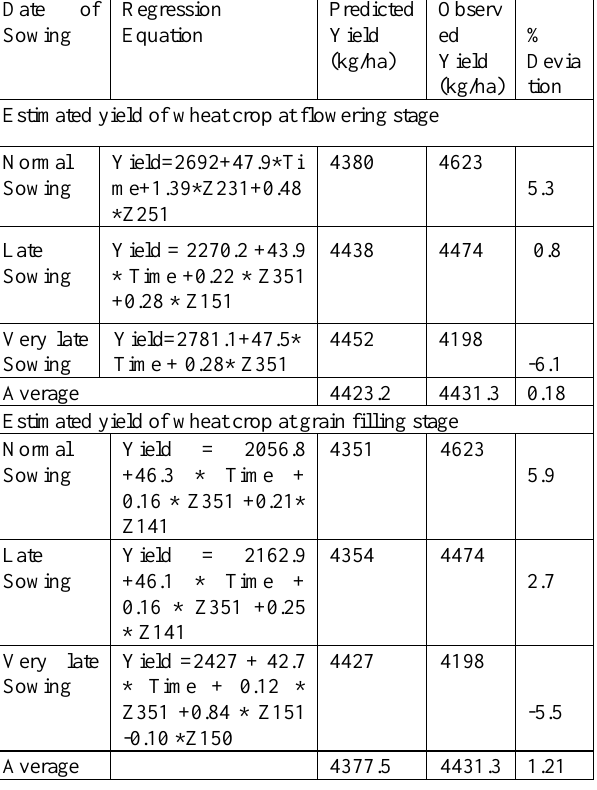
Table 5: Percentage deviation of observed yield from estimated yield of wheat crop by InfoCrop model ( Rabi 2017-18